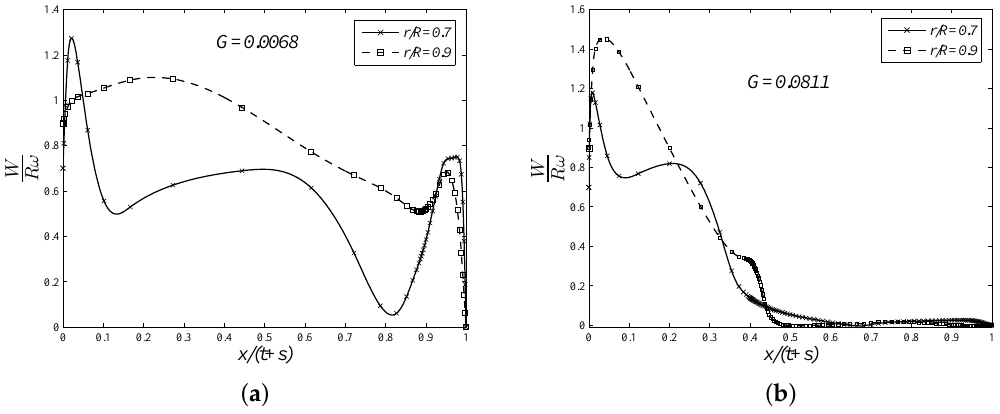
Figure 6. Non-dimensional tangential velocity ( W and L = 0.0540 for ( a ) G = 0.0068; and ( b ) G = 0.0811.